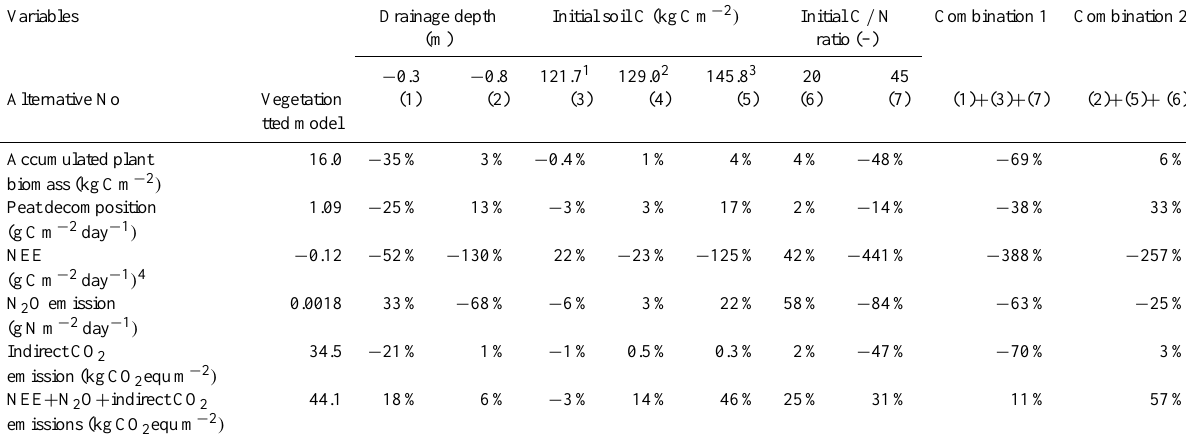
Table 2. Model sensitivity: change compared with “vegetation fitted” model during 1951 to 2011.